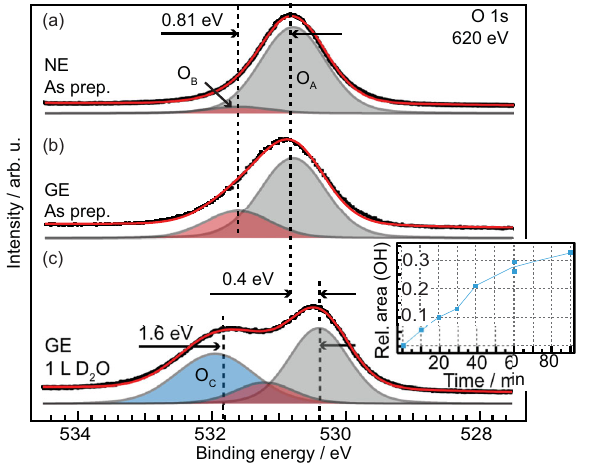
Fig. 2 Measured O 1s core level spectra. a O 1s of ZnO(10 (cid:1) 14) for the as prepared surface measured in normal- and b grazing emission. c O 1s after exposure to 1 L D 2 O at room temperature, grazing emission. Black dots: measured data. Red line: fi tted spectra. Shaded peaks: fi tted components as labeled in the fi gure. Inset: Peak area of the XPS O 1s O C component, normalized to the water saturated spectrum, as a function of time in 1 ⋅ 10 − 10 mbar residual gas, mainly composed of H 2 and H 2 O. Line to guide the eye.